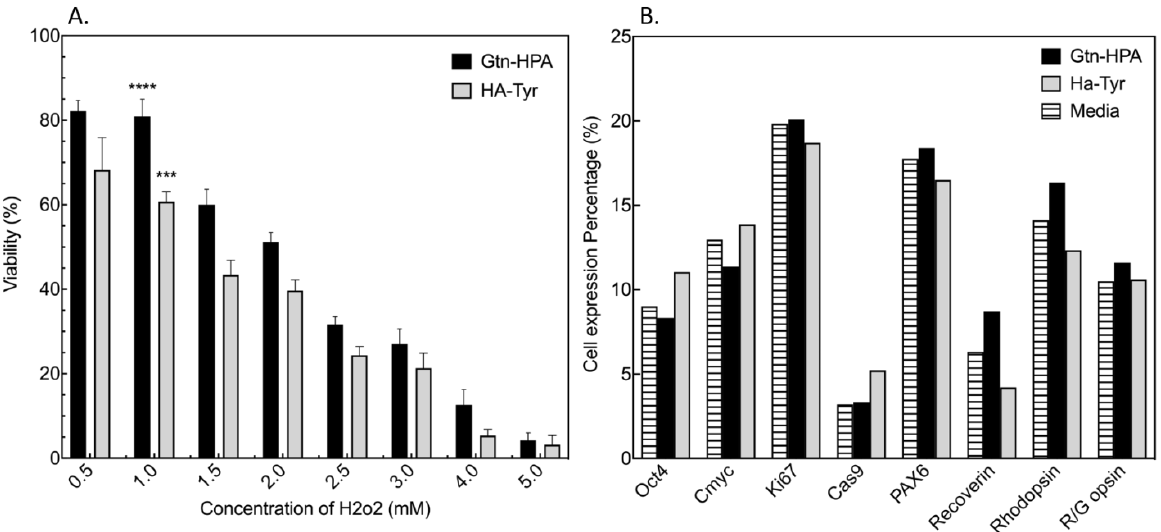
Figure 3. Viability and phenotype assay on hRPCs encapsulated in Gtn-HPA/HA-Tyr after 1 day. ( A ) Viability was measured by counting the number of live and dead cells in the viability assay performed with CalceinAM and Ethidium Bromide. Data of each group were calculated from 15 randomly chosen fields in each group using confocal fluorescence microscopy. Viability was observed to be significantly decreasing with the increase in hydrogen peroxide concentration. **** p = 0.0001; *** p = 0.001. ( B ) hRPCs cultured with media or in Gtn-HPA were analyzed for their phenotype with flow cytometry. No significant difference was observed at short time between both groups for all retinal, stemness, rods, cones, proliferation and apoptosis markers.